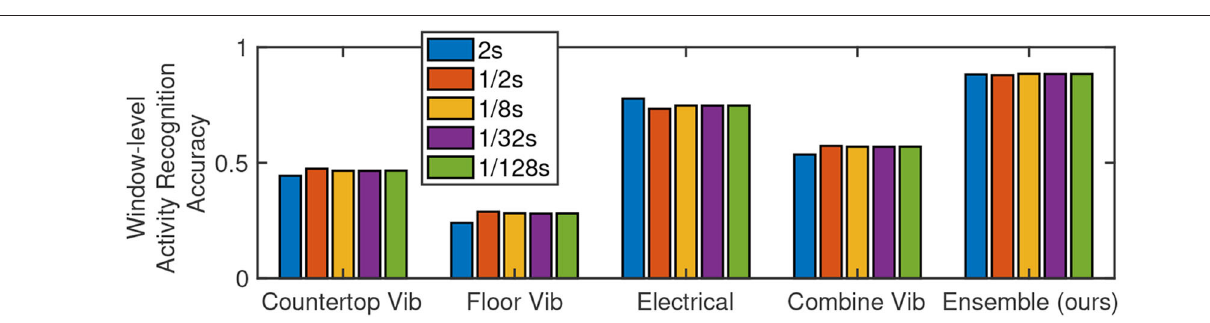
FIGURE 12 | ADL recognition accuracy at different temporal resolution (different window sizes area